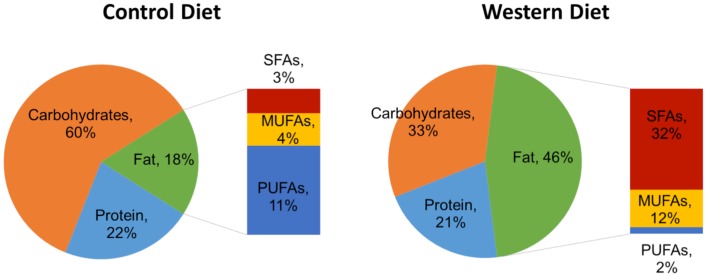
Comparison of guinea pig dietary models by macronutrient composition.Control Diet (feed caloric density = 3.4 kcal/g; left), and Western Diet (feed caloric density = 4.2 kcal/g; right). Macronutrient percentages are by calories. SFA = Saturated fatty acids; MUFA = Monounsaturated fatty acids; PUFA = Polyunsaturated fatty acids.